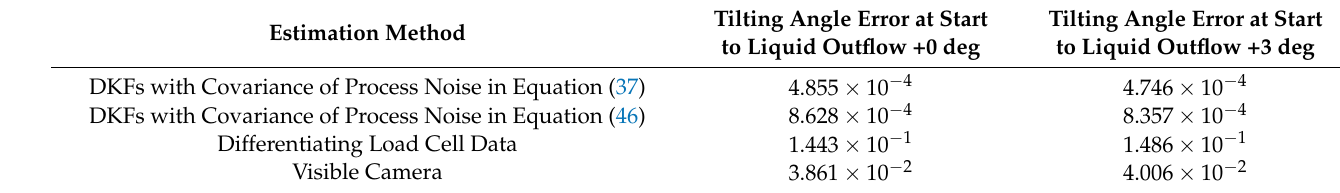
Table 2. Total variations (TVs) of estimated flow rates.